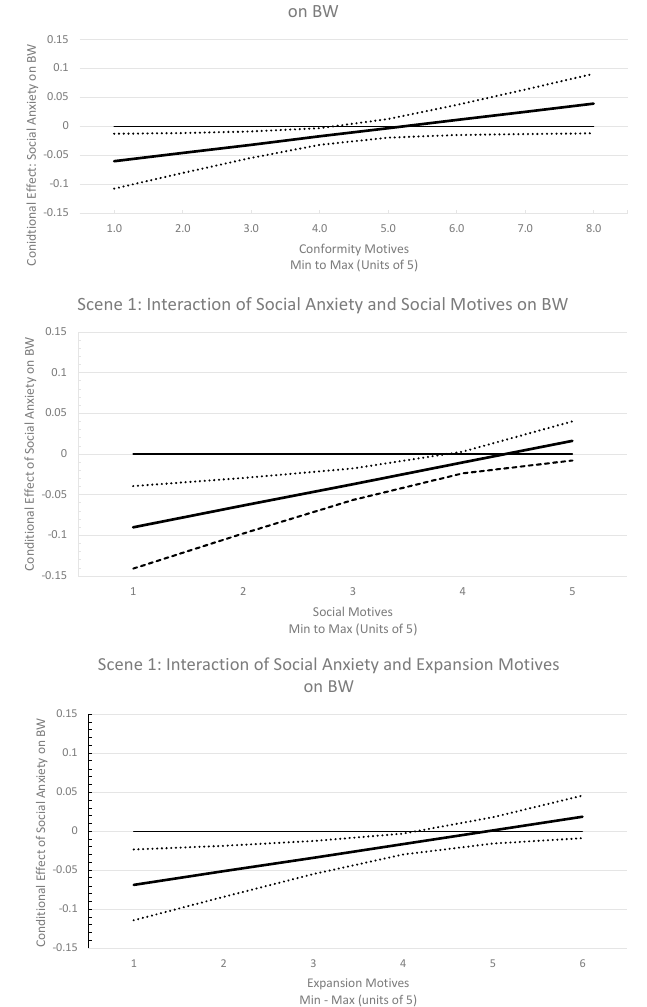
Figure 1. Visualizations of interactions in scene 1 (card game). Solid lines indicate the conditional effect of social anxiety on behavioral willingness at unit levels of cannabis use motives, ranging from the minimum to maximum values. Dotted lines represent the 95% confidence interval around these estimates.